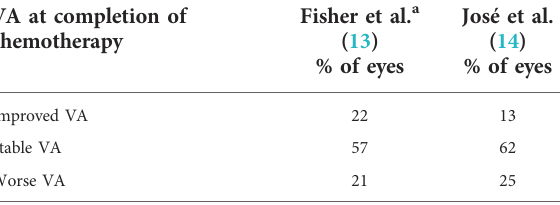
TABLE 1 Comparison of visual outcomes of optic pathway glioma in neuro fi bromatosis treated with chemotherapy. VA at completion of